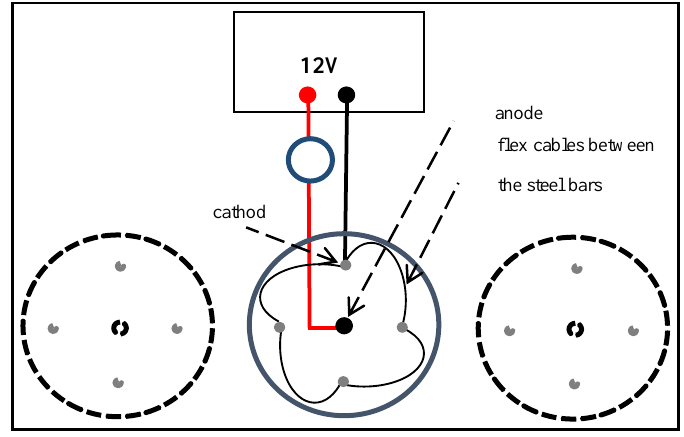
Figure 8. Schematic arrangement for the corrosion process.